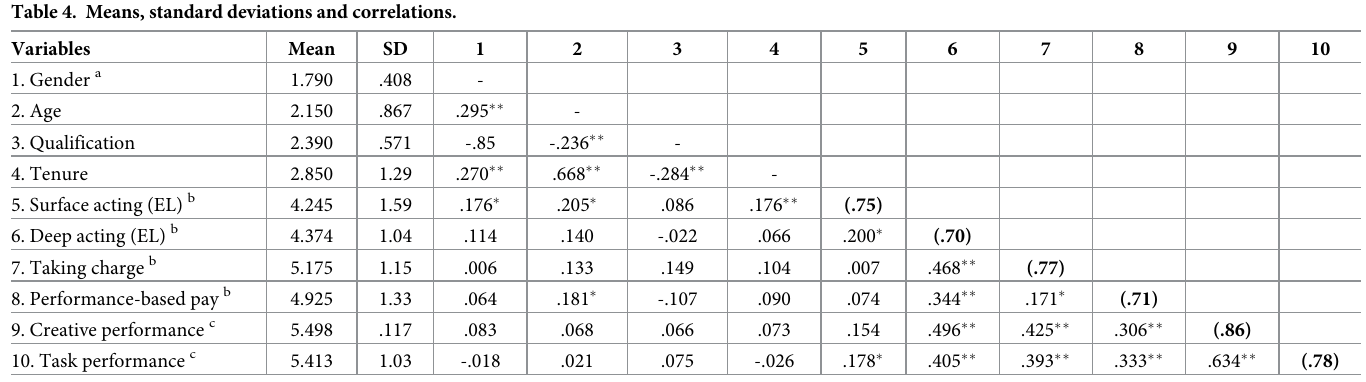
Note : ns = 417 individuals from 186 Teams. a Female = 1, Male = 2 b Rated by team members. c Rated by team leaders. � p < 0.05 �� p <